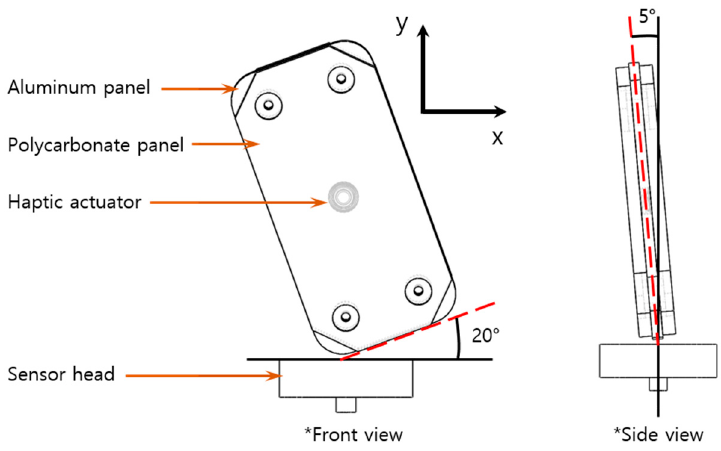
Figure 4. Drop impact analysis